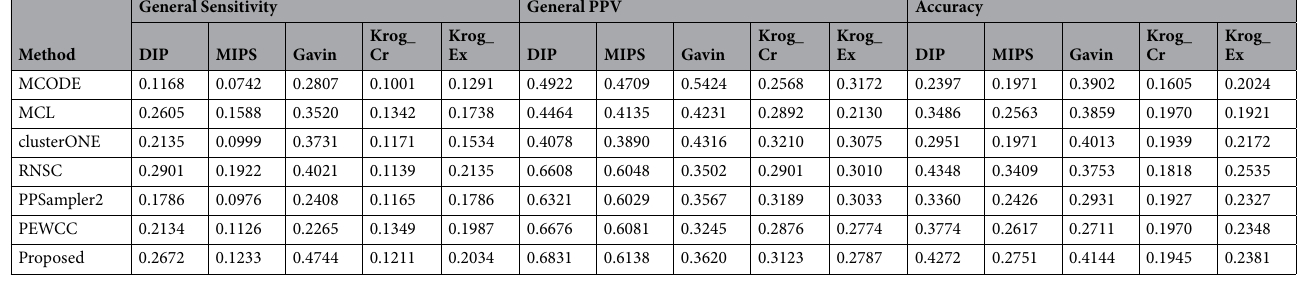
Table 3. Comparisons of results with respect to sensitivity, specificity and accuracy.